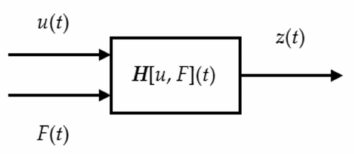
Figure 2. The hysteresis characteristic of the